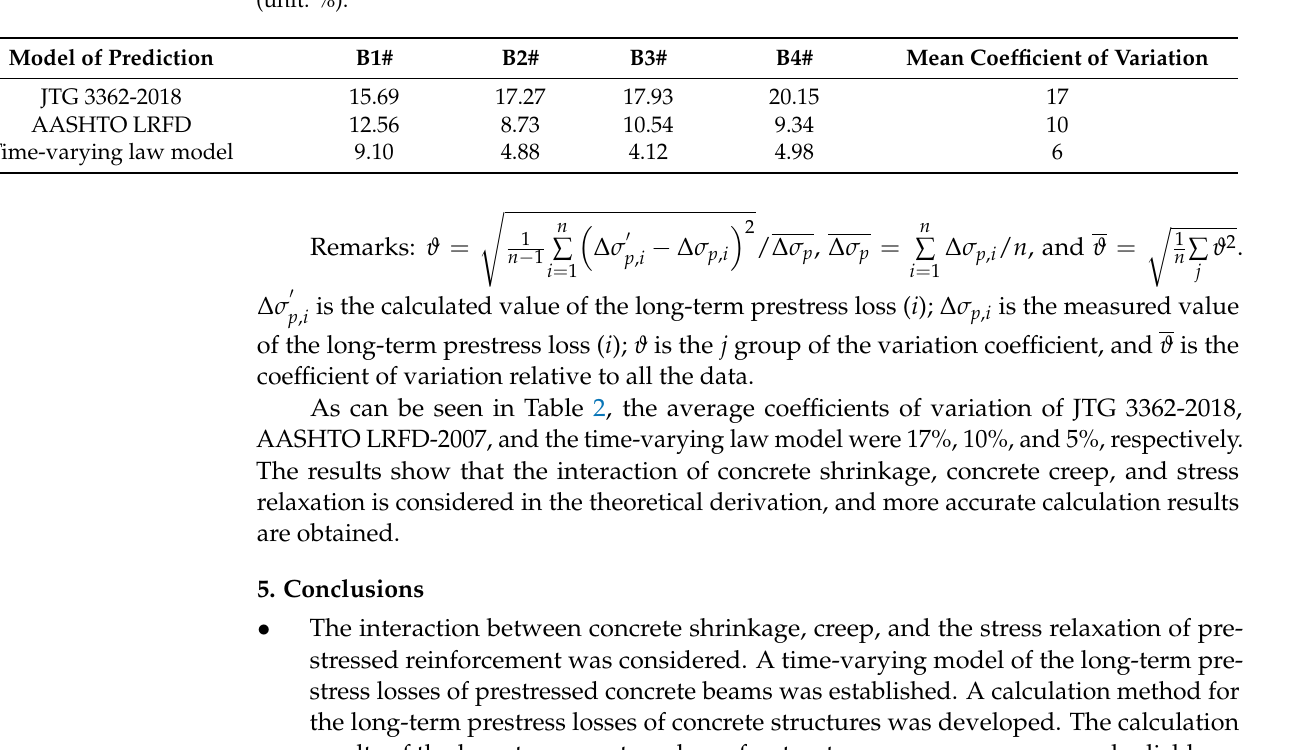
Table 2. The coefficient ( ϑ ) of variation of each predictive model relative to the measured values (unit: